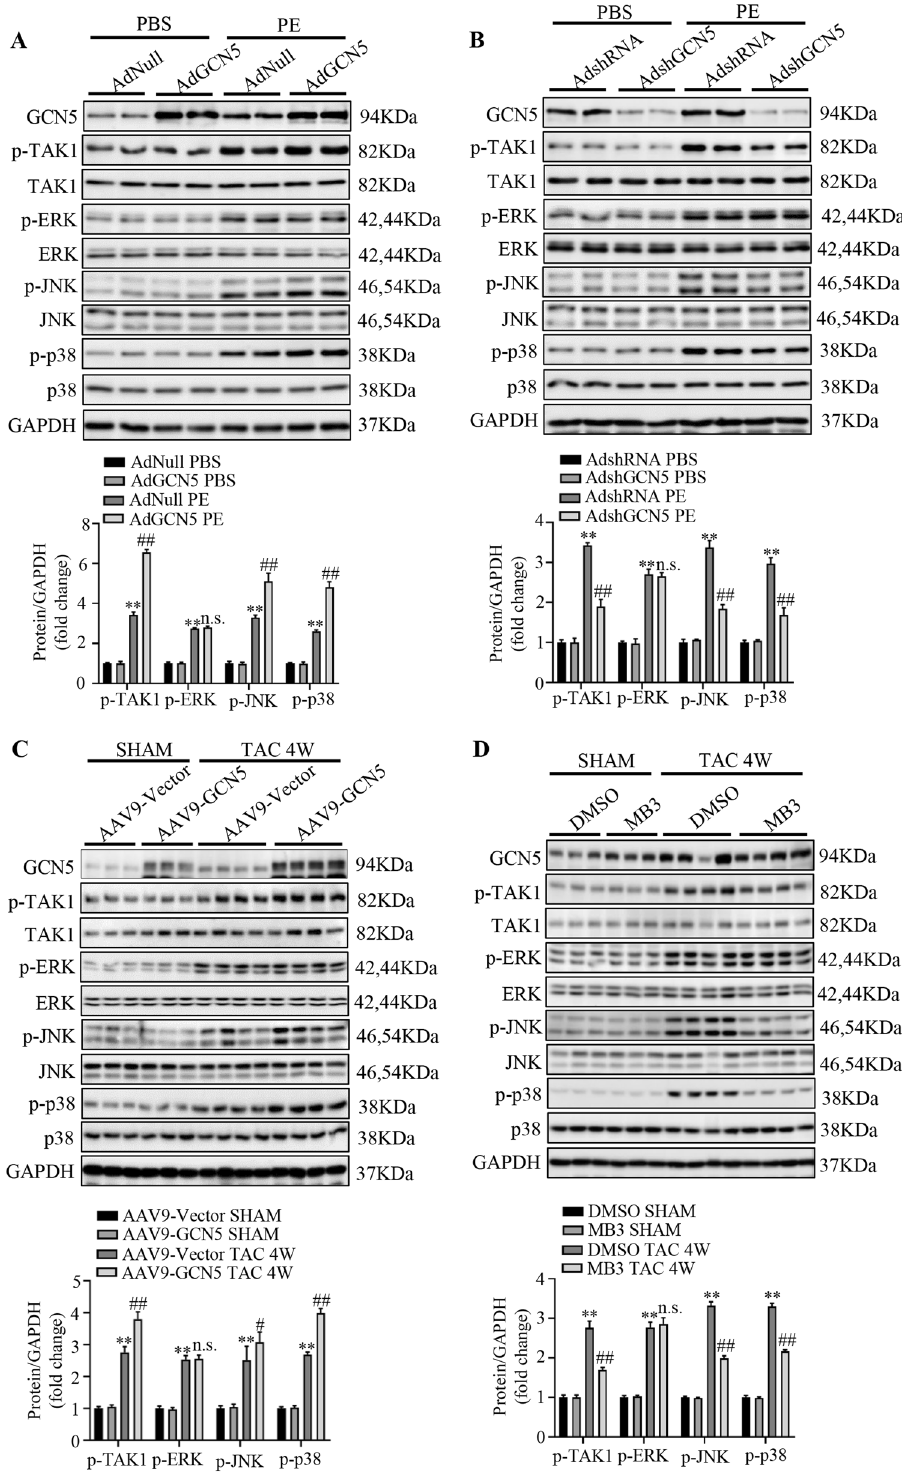
Fig. 5 GCN5 regulates TAK1-JNK/p38 signaling pathway in hypertrophic hearts and cardiomyocytes. A Western blots showing the activity of TAK1-JNK/p38 signaling pathway components in NRCMs infected with AdNull or AdGCN5 for 24 h, followed by treatment with PBS or PE ( ∗∗ P < 0.01 vs AdNull PBS; n.s., ## P < 0.01 vs AdNull PE). B Western blots showing the activity of TAK1-JNK/p38 signaling pathway components in NRCMs infected with AdshRNA or AdshGCN5 for 24 h, followed by treatment with PBS or PE ( ∗∗ P < 0.01 vs AdshRNA PBS; n.s., ## P < 0.01 vs AdshRNA PE). C Western blot showing the activity of TAK1-JNK/p38 signaling pathway components in the hearts of GCN5-overexpressing mice or control mice subjected to sham or TAC surgery at 4 weeks ( n = 7 – 9 mice/group, ∗∗ P < 0.01 vs AAV9-Vector SHAM; n.s., # P < 0.05, ## P < 0.01 vs AAV9-Vector TAC 4 W). D Western blot showing the activity of TAK1-JNK/p38 signaling pathway components in the hearts of GCN5- inhibited mice or control mice subjected to sham or TAC surgery at 4 weeks ( n = 7-8 mice/group, ∗∗ P < 0.01 vs DMSO SHAM; n.s., ## P < 0.01 vs DMSO TAC 4